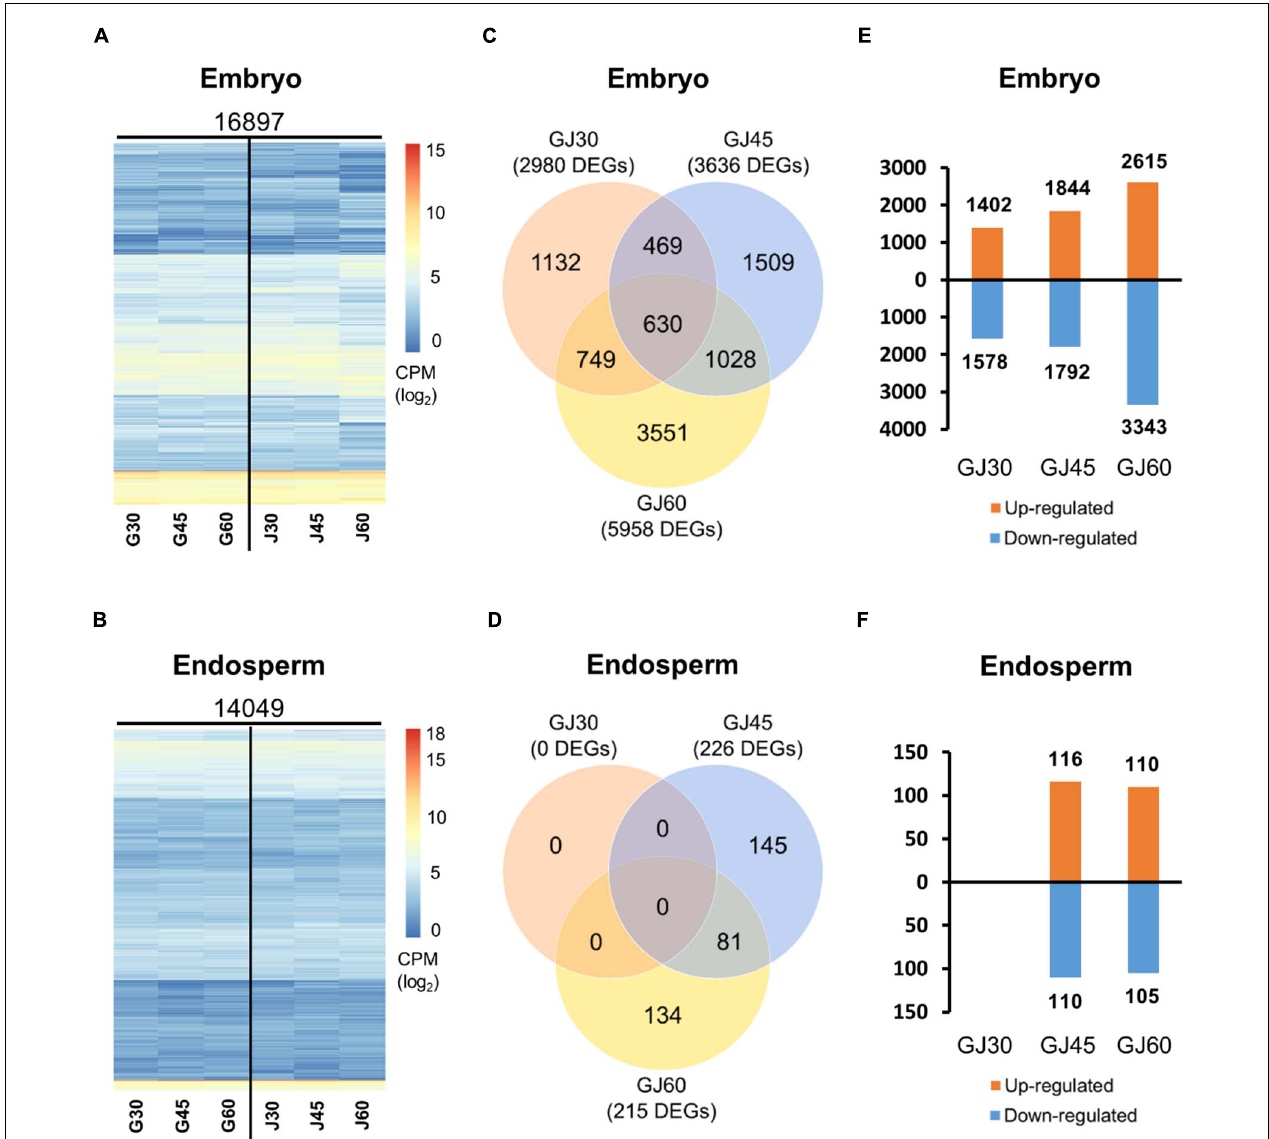
FIGURE 2 | Identification of differentially expressed genes (DEGs) based on the RNA-seq data of the embryo and endosperm of Gopum and Jowoon. (A,B) Heatmaps of expressed genes in the embryo (A) and endosperm (B) of Gopum and Jowoon, respectively. Expressed genes, mapped onto the International Rice Genome Sequencing Project (IRGSP) rice reference genome sequence, are shown as log-transformed counts per million (CPM) values. G30, G45, G60, J30, J45, and J60 indicate Gopum and Jowoon samples at 30, 45, and 60 DAH, respectively. (C,D) Comparison of Gopum and Jowoon based on the number of DEGs in the embryo (C) and endosperm (D) . GJ30, GJ45, and GJ60 indicate the comparisons between Gopum and Jowoon at 30, 45, and 60 DAH, respectively. (E,F) Numbers of genes up- or down-regulated in Jowoon compared with those in Gopum in the embryo (E) and endosperm (F) of GJ30, GJ45, and